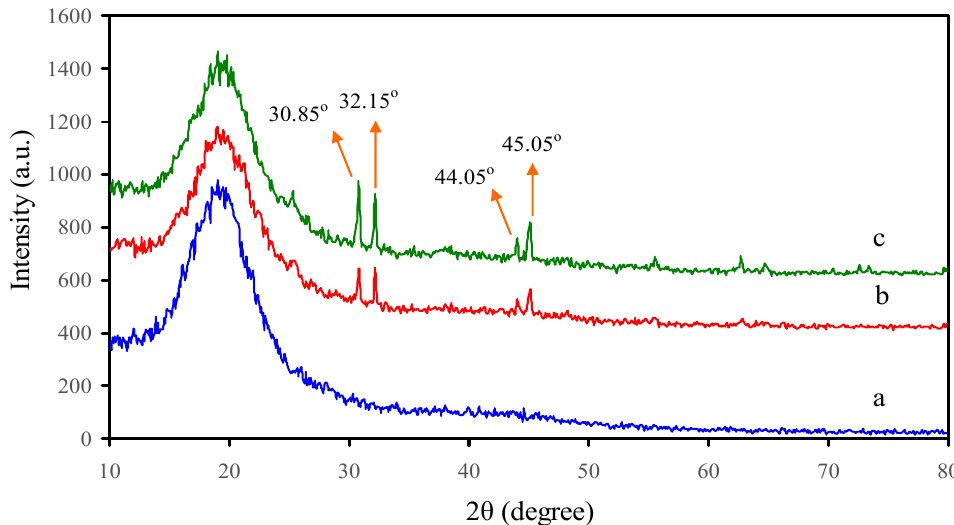
Figure 1. X-ray di ff raction pattern for a—pure PS (PSSNT0), b—PSSNT1, and c—PSSNT2 Figure 1. X-ray diffraction pattern for a—pure PS (PSSNT0), b—PSSNT1, and c—PSSNT2 nanocomposite nanocomposite films.